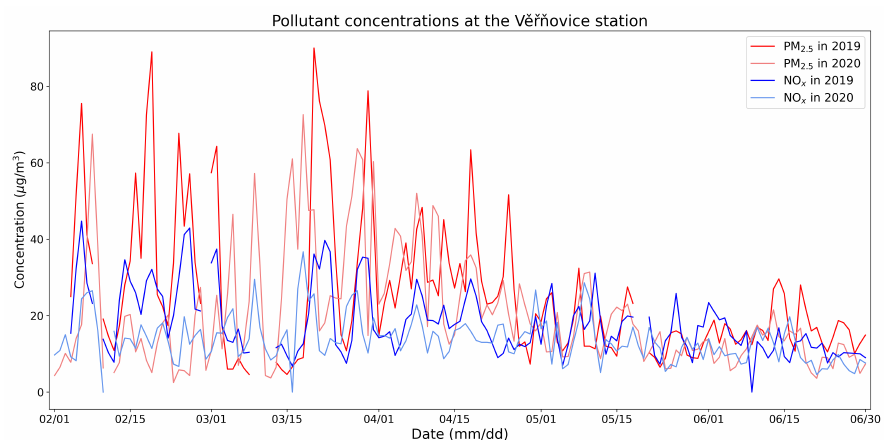
Figure A6. Daily average concentrations at the Vˇeˇrˇnovice station.